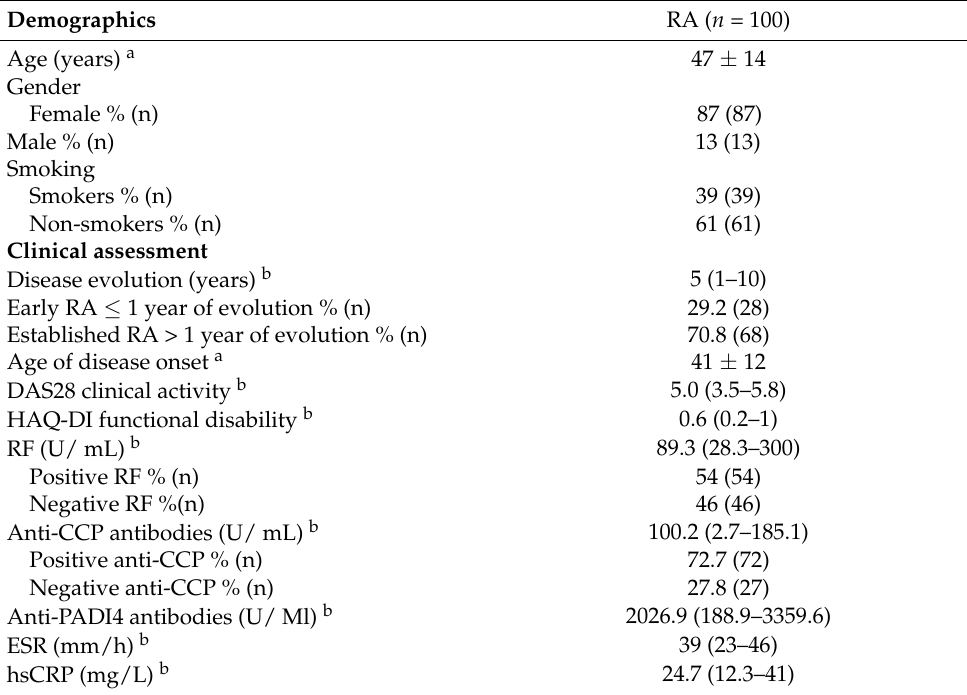
Table 1. Clinical and demographic characteristics of RA